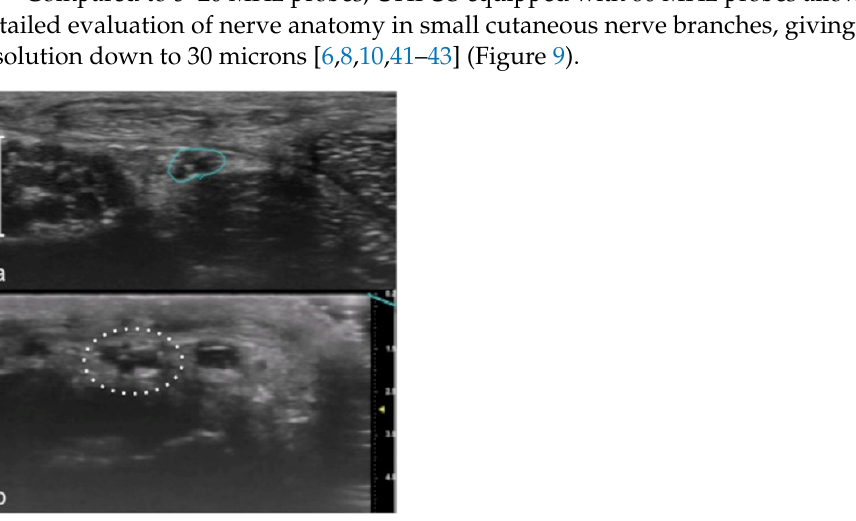
Figure 8. Same patient as in Figure 7. 1.5 T MRI shows a mass-like area (arrowhead) proximal to the joint representing the injured and displaced ligament in (a). In ( b ), the contralateral metacarpal phalangeal joint of the thumb. M: metacarpal head.